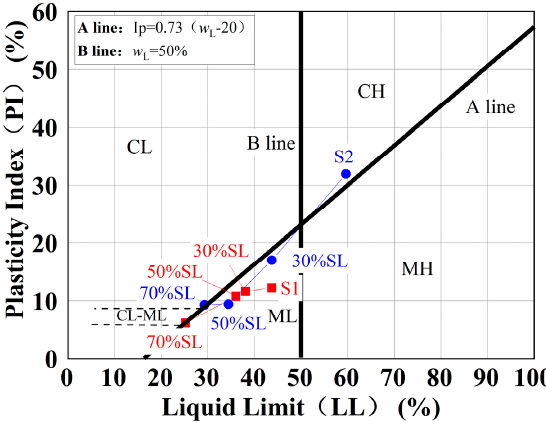
Figure 7. The plastic zones of soil specimens in this